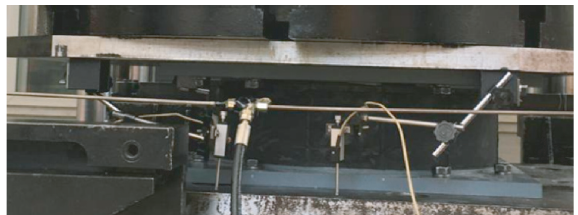
Figure 12: Schematic diagram of the installation of the bearing and displacement meter.